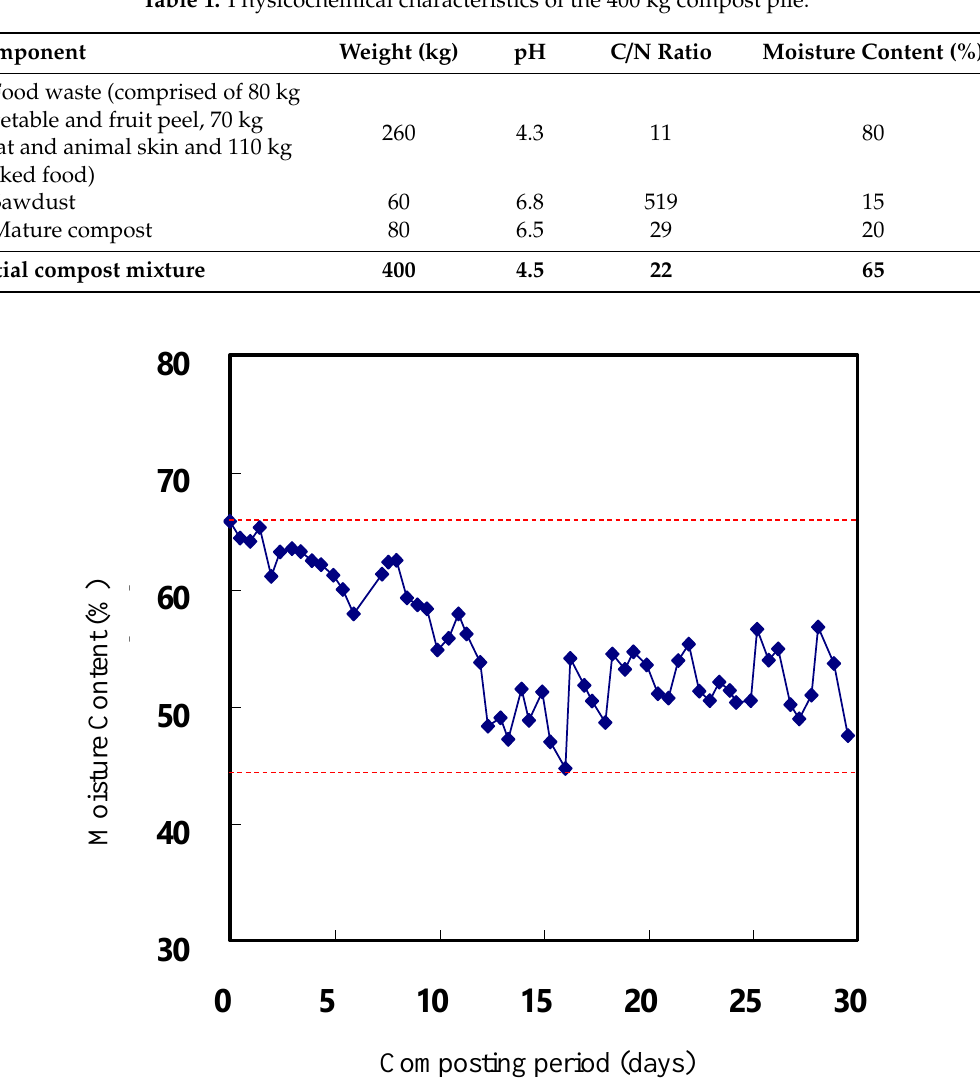
Figure 2. Moisture content variation during the composting period.